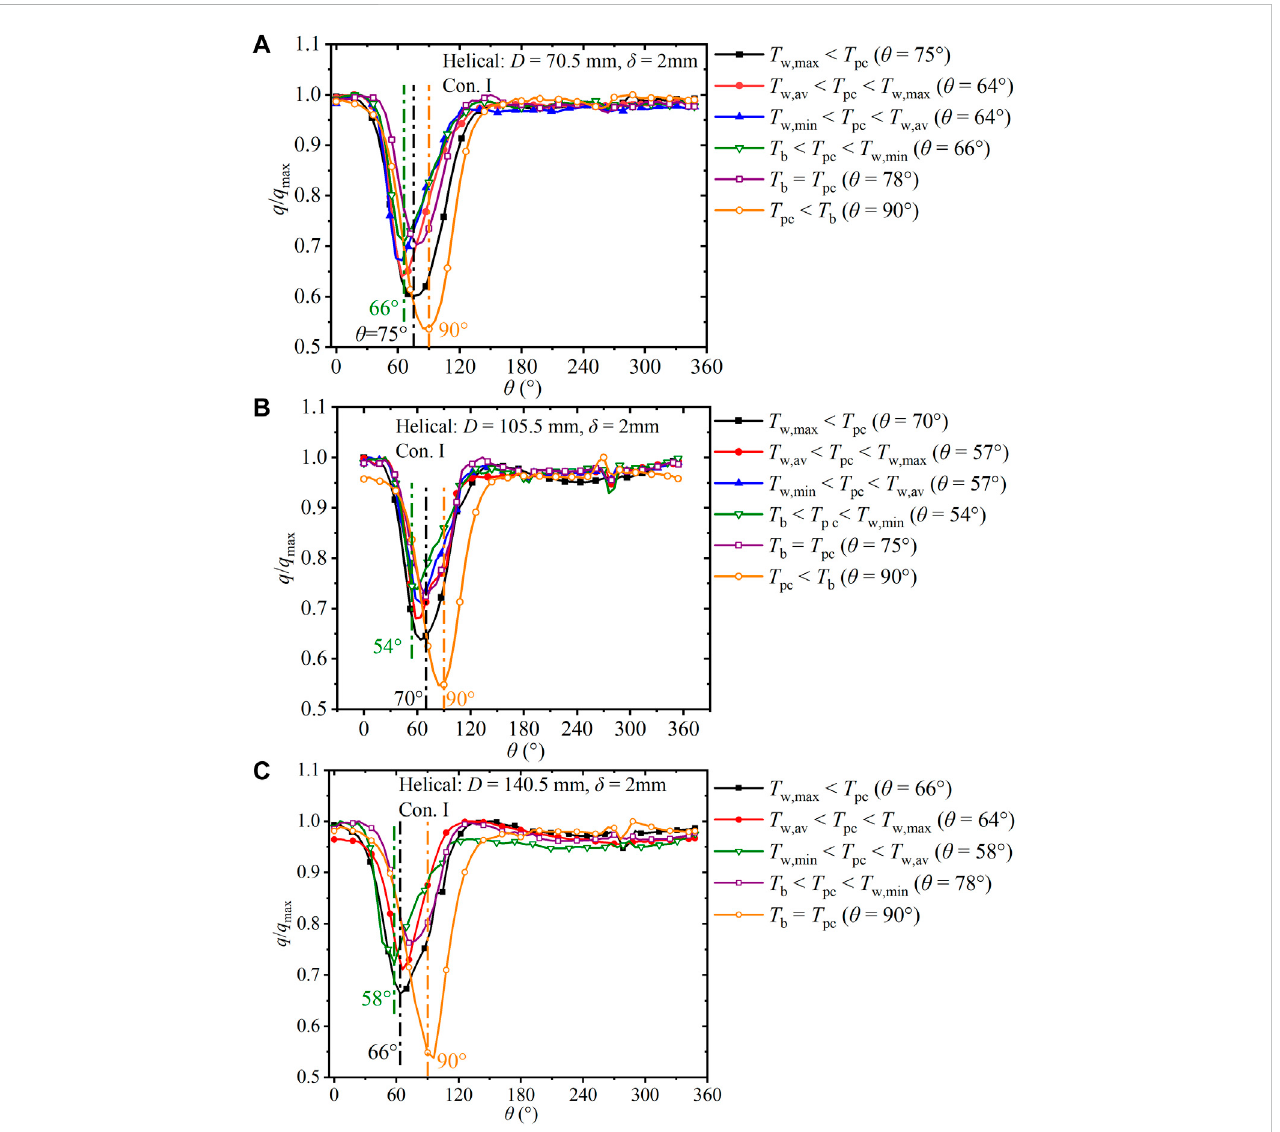
Development of circumferential dimentionless heat fl ux in helical tubes versus θ ( δ = 2 mm, Con. I: G in = 225 kg). (A) D = 70.5 mm; (B) D = 105.5 mm; (C) D = 140.5